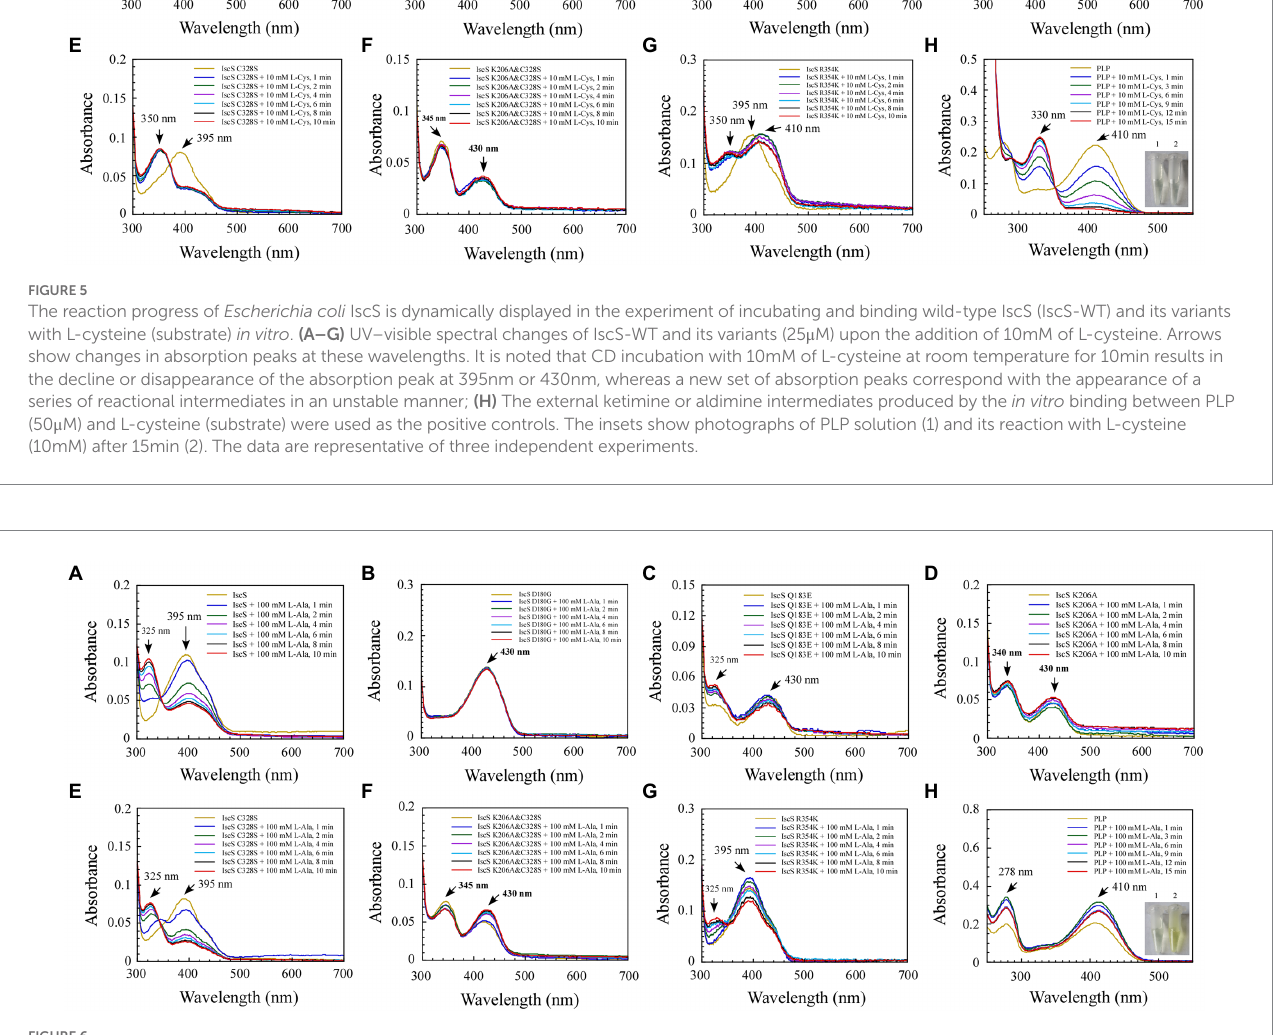
FIGURE 6 Changes in the absorption spectrum of IscS-WT and its variants associated with the formation of reaction with the L-alanine (product) in vitro . (A–G) Time- dependent spectral analysis of L-alanine binding to IscS-WT and its variants; (H) UV–visible spectral changes of 50 μ M PLP upon the addition of 100 mM L-alanine (product). The insets show photographs of PLP solution (1) and its reaction with L-alanine after 15 min (2). The data are representative of three independent